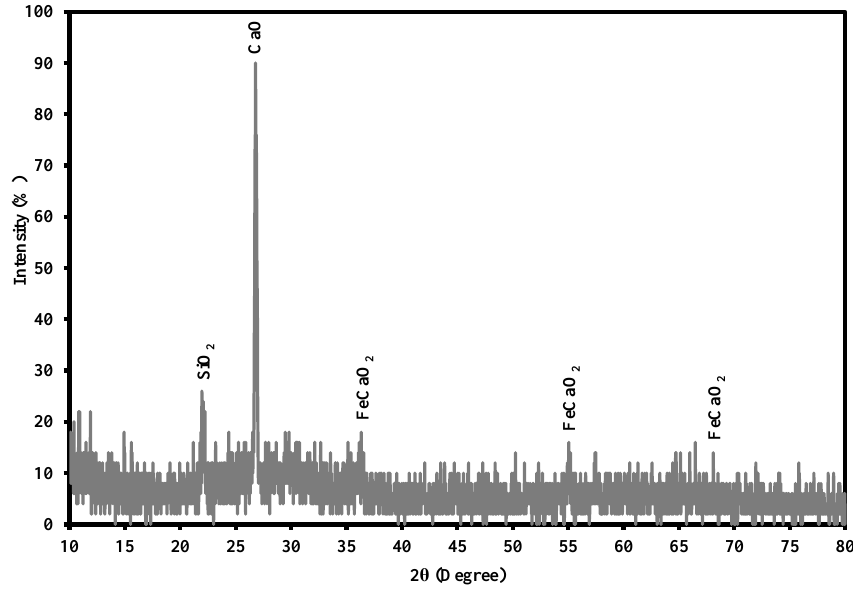
Figure 1. X-ray diffractogram of granular iron slag. Figure 1. X-ray di ff ractogram of granular iron